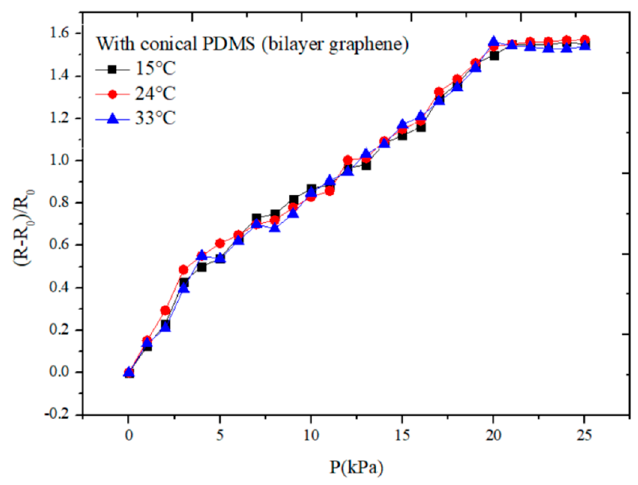
Figure 11. The sensitivity curves of the sensor with the bilayer graphene under different temperatures of 15, 24, and 32 °C, respectively.